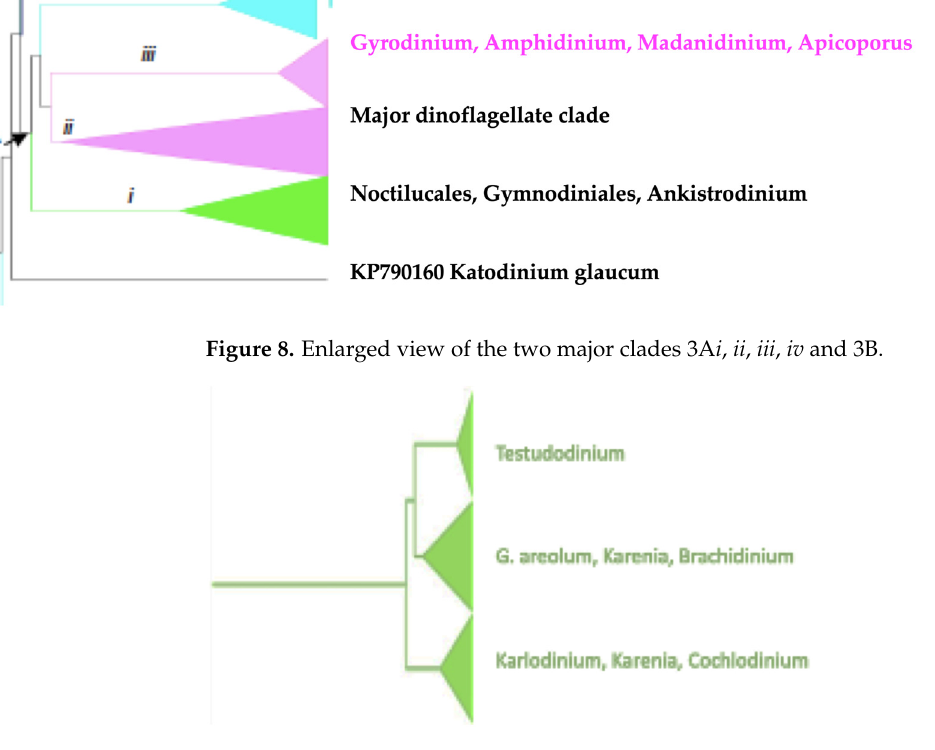
Figure 9. Enlarged view of clade 3B.